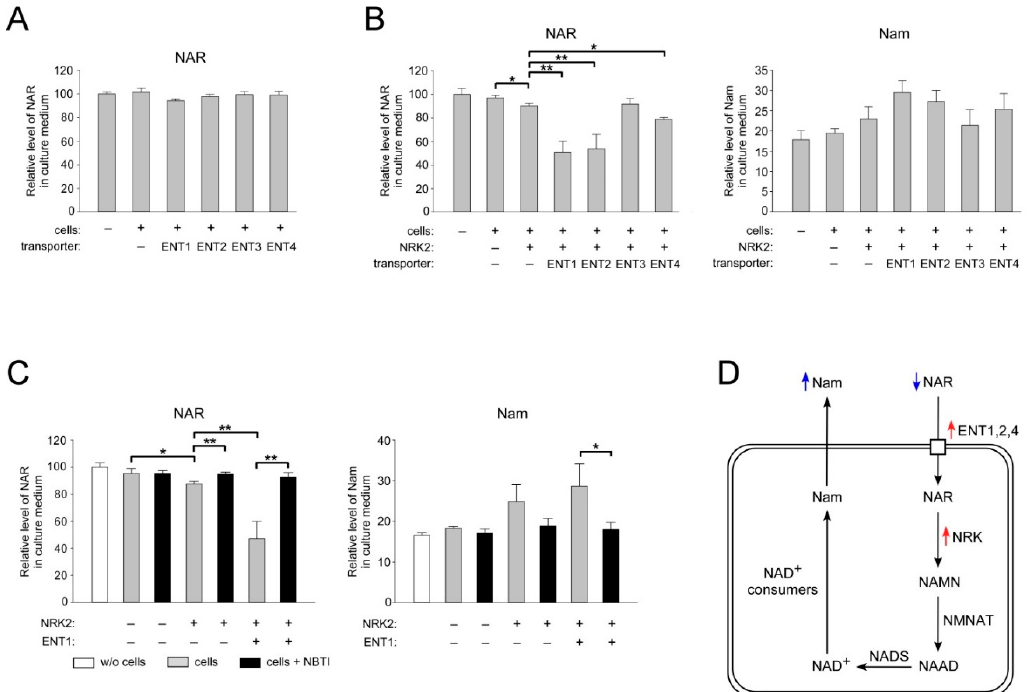
Figure 4. Co-expression of NRK2 and ENT1, ENT2, or ENT4 stimulates NAR uptake into HEK293 cells. HEK293 cells cultivated in DMEM were transiently transfected with vectors encoding FLAG-tagged ENT1, -2, -3, or -4 or control (empty) vector ( A ). Cells were also cotransfected with a vector encoding FLAG-tagged NRK2 as indicated ( B ), ( C ). Twenty-four hours after transfection, cells were treated with nicotinic acid riboside NAR (100 µM). In ( C ), cells were additionally treated with NBTI (10 µM) as indicated. Twenty-four hours after treatment, culture medium was analyzed by NMR spectroscopy. Relative levels of NAR and Nam in culture medium are presented. The amount of NAR in control culture media incubated without cells was taken as 100. Data are presented as mean ± S.D ( n = 3). Statistical analysis of differences between the groups was carried out by one-way ANOVA with post hoc comparisons using Tukey test. * indicates statistical significance at p < 0.05, ** indicates statistical significance at p < 0.01. ( D ) Schematic interpretation of the results shown in ( A – C ). Blue arrows: changes in extracellular metabolite concentrations; red arrows: overexpressions of FLAG-tagged proteins. This observation implies that NAR is not utilized by HEK293 cells as actively as NR